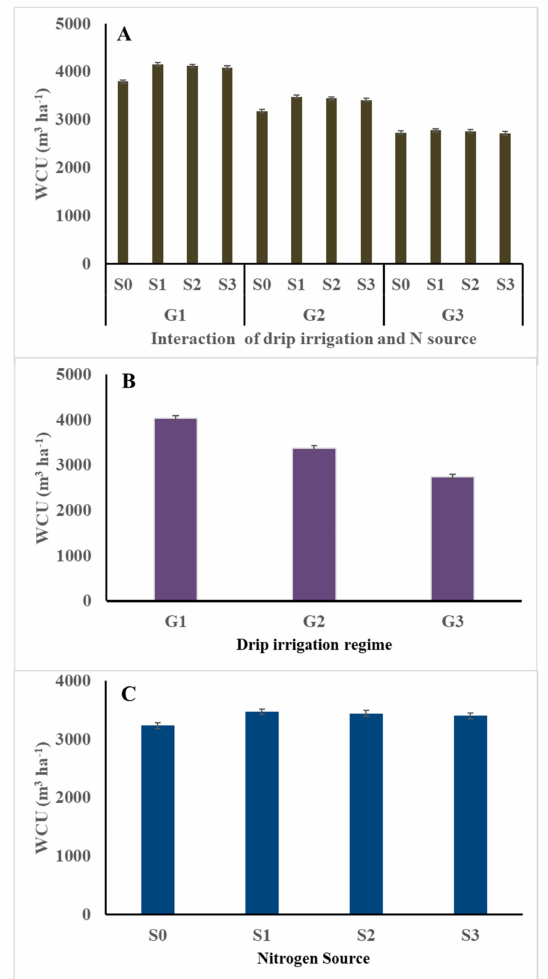
Figure 1. Average e ff ect of drip irrigation regime ( B ), and its interaction with N source ( A ) on water consumptive use (WCU; m 3 ha − 1 ) by potato (average of the two seasons). G 1 = 120% ETc irrigation; G 2 = 100% ETc irrigation; G 3 = 80% ETc irrigation; S 0 = Unfertilized (control); S 1 = Urea; S 2 = Ammonium nitrate; S 3 = Ammonium sulfate; and Error bars = Standard error of means